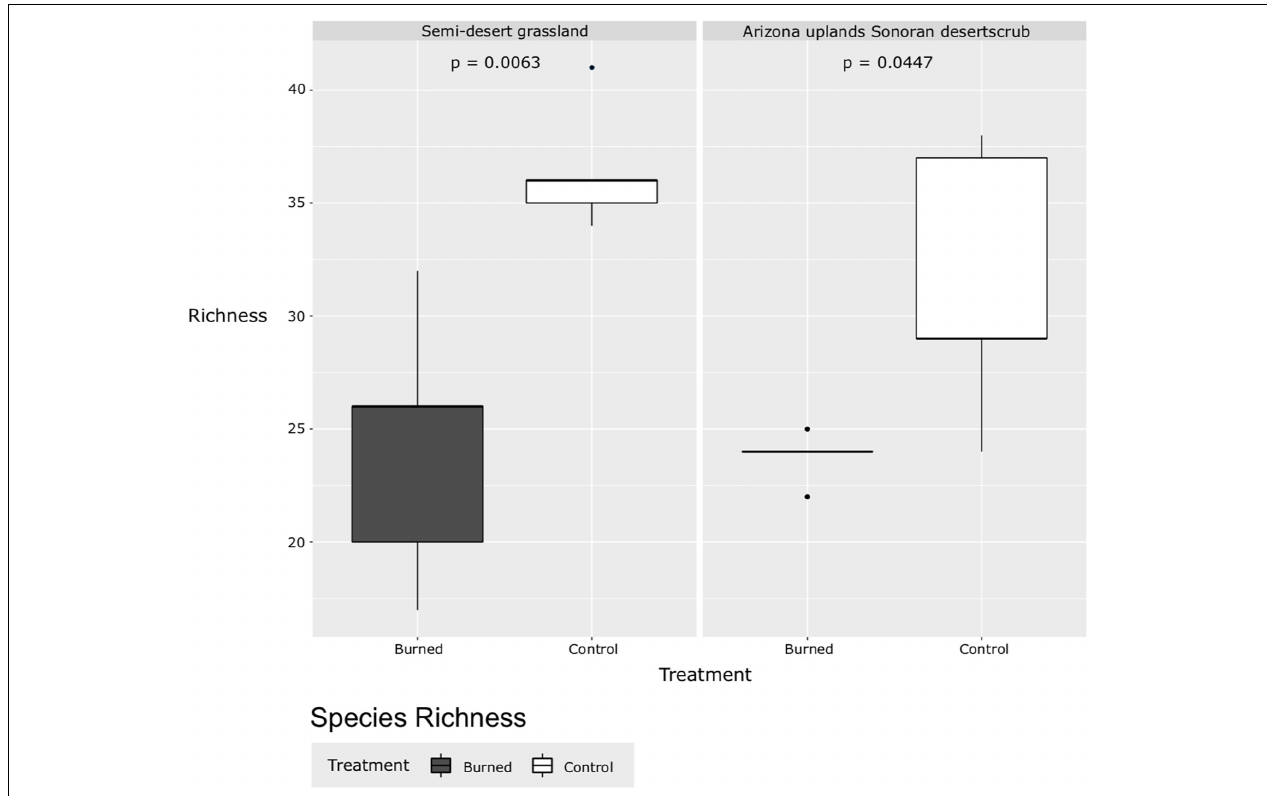
FIGURE 7 | Species richness of burned and control plots, Catalina State Park, Tucson,